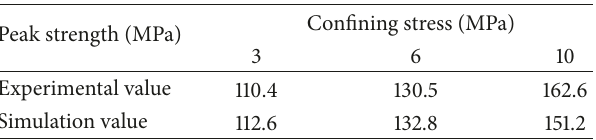
Table 2: Peak strength of granite and the bonded particle model under different confining stresses.